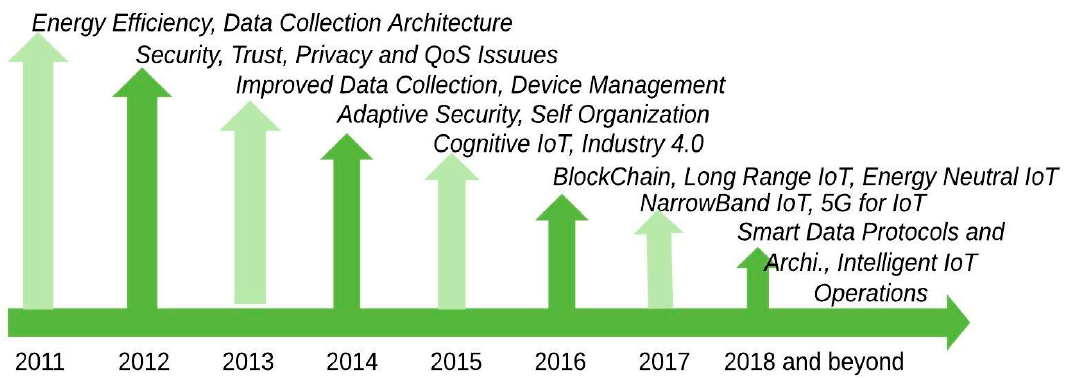
Figure 1. Notable research areas for IoT over the last decade.